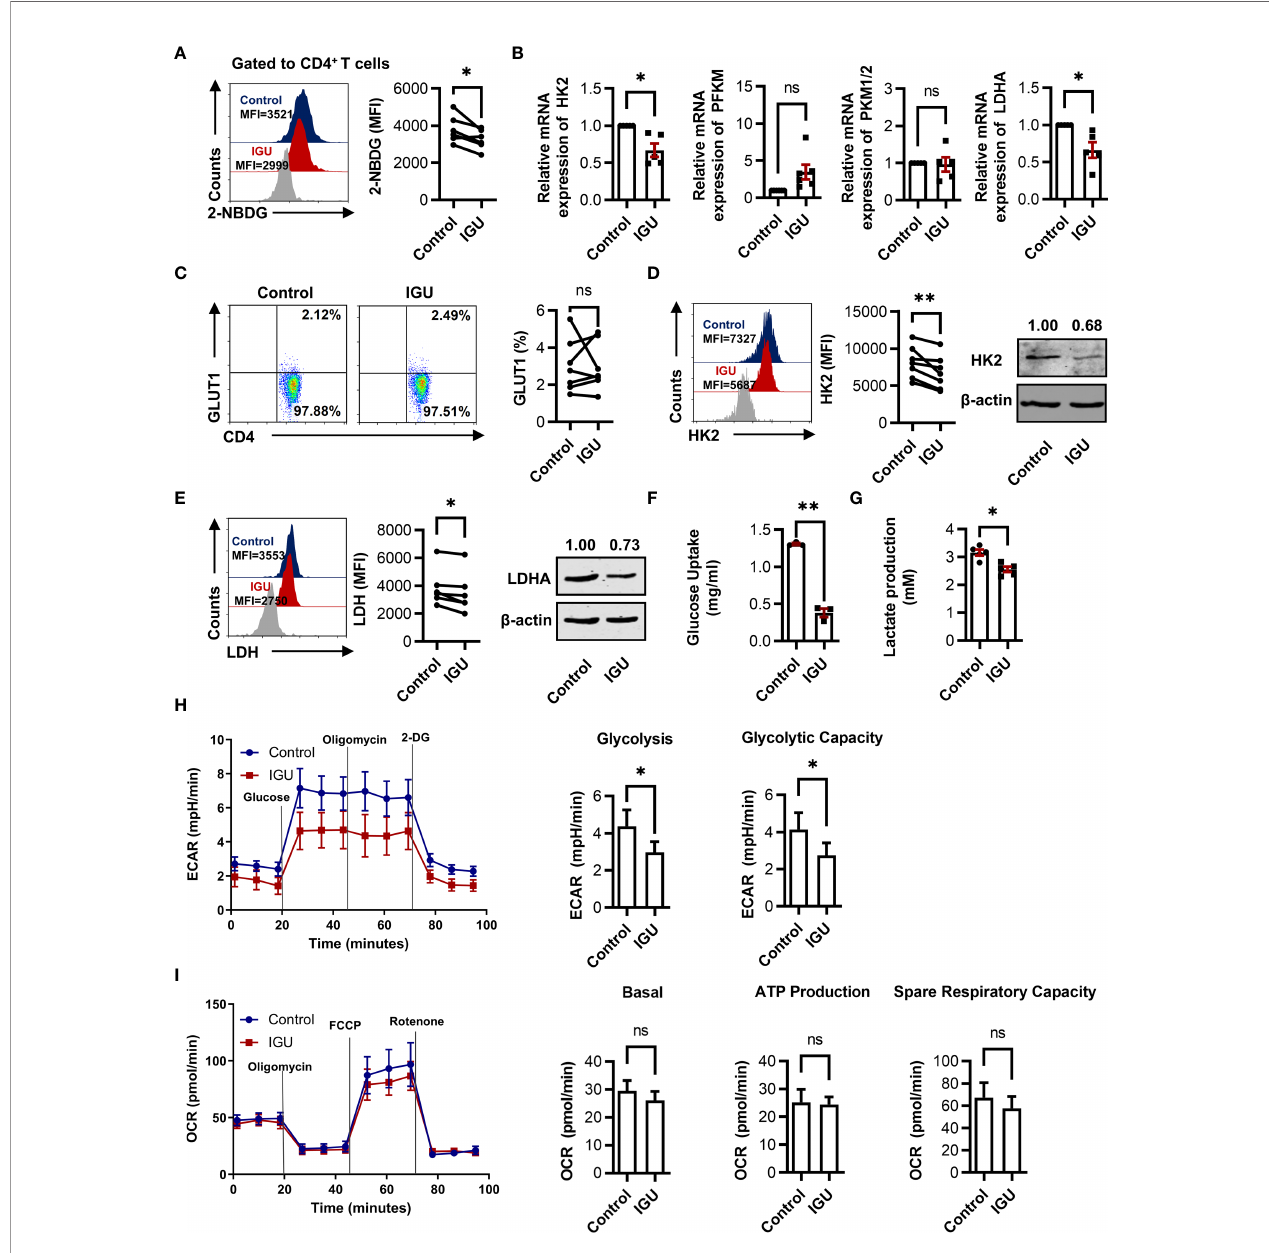
FIGURE 4 | IGU inhibits glucose metabolism in RA-CD4 + T cells. (A) RA-PBMCs were cultured in the presence of DMSO or IGU for 24 hours, then the glucose uptake was determined by the 2-NBDG method (n = 6). (B) Puri fi ed RA-CD4 + T cells were cultured in the presence of IGU or DMSO for 24 hours, and relative mRNA expression levels of HK2, PFKM, PKM1/2, and LDHA were determined by qPCR. Expression levels of each gene were normalized to b -actin expression level and adjusted to the levels in the control group (served as 1). (C-E) GLUT1 (n = 7), HK2 (n = 8), and LDH (n = 6) in RA-CD4 + T cells were measured by fl ow cytometry and western blotting. (F, G) Puri fi ed RA-CD4 + T cells were cultured in the presence of IGU or DMSO for 24 hours. Glucose uptake (n = 3) and lactate production (n = 5) in the culture supernatants were determined by the glucose and lactate assay kit. (H, I) RA-CD4 + T cells were activated by anti-CD3/CD28 for 24 hours, then treated with DMSO or IGU for 1 hour. ECAR (n = 5) and OCR (n = 5) for each group were measured in real-time under basal conditions and after addition of the indicated reagents. The data of glycolysis, glycolytic capacity, basal OCR, ATP production, and spare respiratory capacity were shown. MFI: mean fl uorescence intensity. Symbols represent individual subjects. ns, no signi fi cance; * P < 0.05; ** P